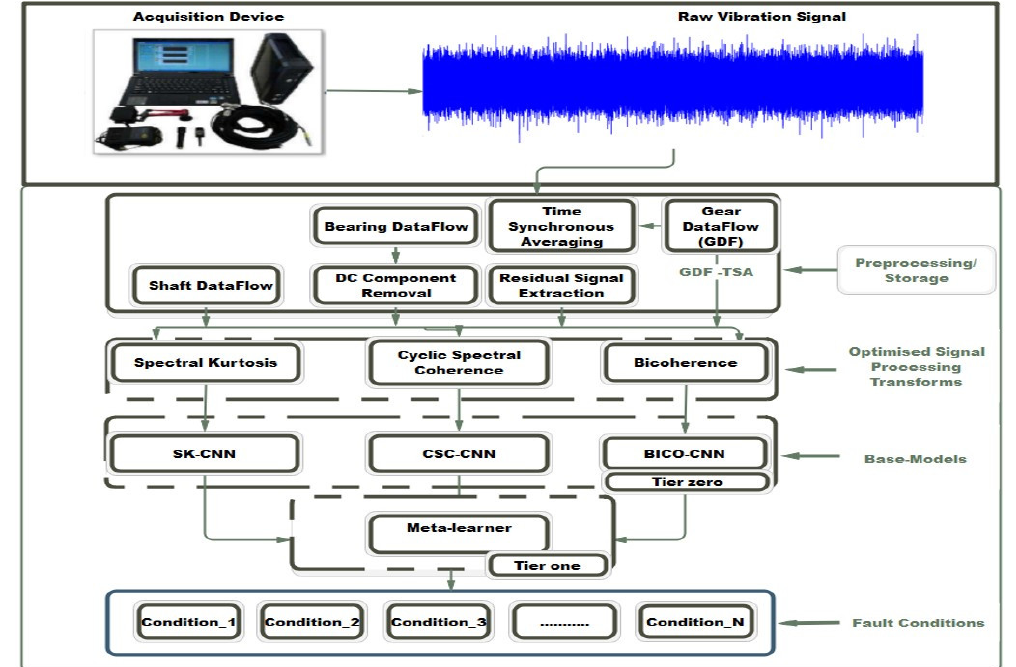
Figure 1. Proposed multiple faults diagnosis framework.